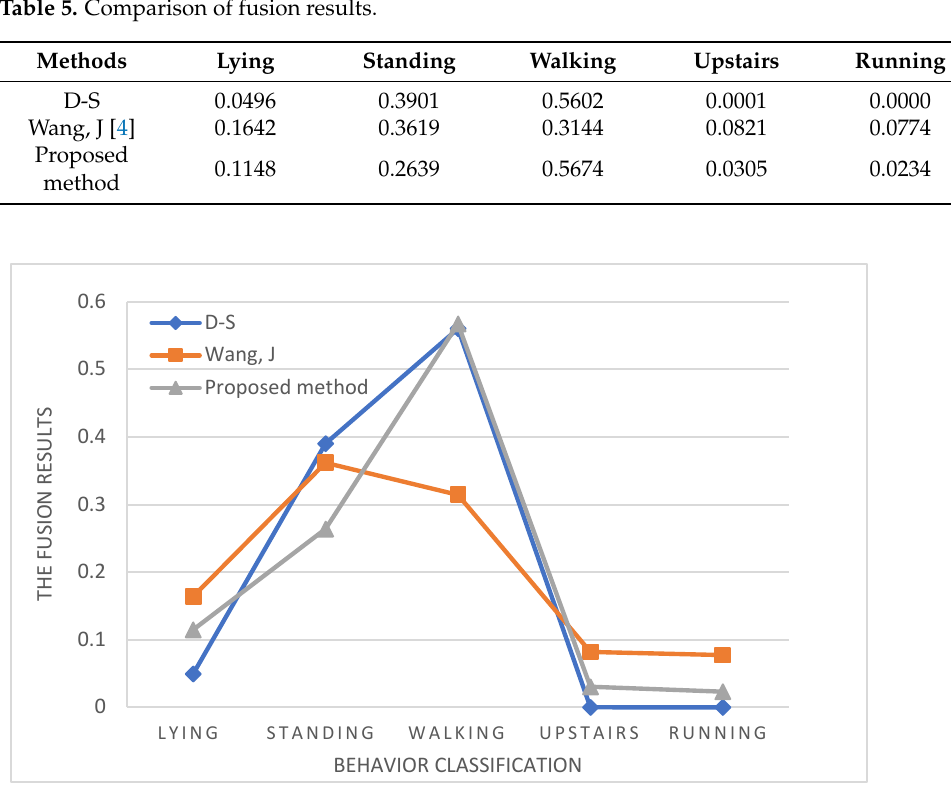
Figure 2. Fusion results of different methods [4].